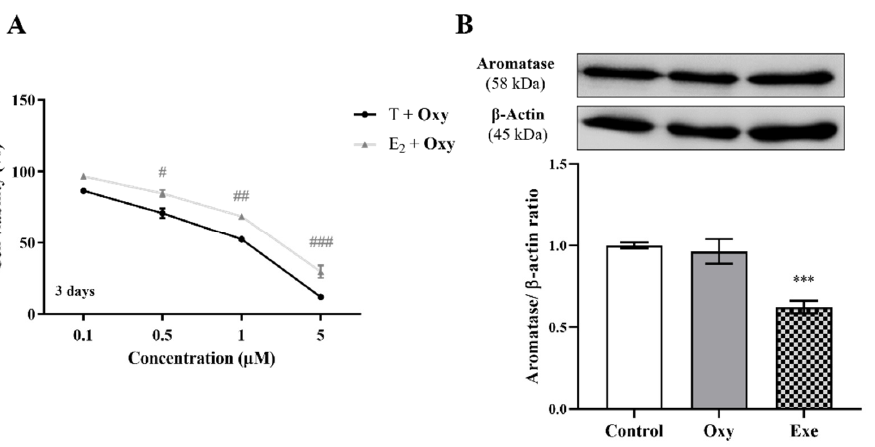
Figure 4. Involvement of aromatase in the effects induced by Oxy on breast cancer cells. ( A ) Effects of Oxy (0.1–5 µ M) on viability of MCF-7aro cells stimulated with T (1 nM) or E 2 (1 nM), after 3 days of exposure. ( B ) Effects of Oxy (1 µ M) on aromatase protein expression levels of MCF-7aro cells, after 8 h. Cells without Oxy treatment were considered as control. Exe at 10 µ M was used as a reference AI. For Western Blot, β -actin was used as a loading control, with the densitometry results presented as aromatase/ β -actin ratio. The protein expression obtained for treated cells was normalized in relation to protein expression of control. Results are presented as the mean ± SEM of at least three independent experiments, each performed in triplicate. Significant differences be ‐ tween T ‐ treated and E 2 ‐ treated cells are denoted by # ( p < 0.05), ## ( p < 0.01) and ### ( p < 0.001), while significant differences between the control and Exe ‐ treated cells are shown by *** ( p < 0.001). Regarding ER α , the results demonstrated that, in the presence of the ER α antagonist ICI, Oxy was unable to reduce cell viability, and a significant increase ( p < 0.001) in cell viability was even observed when compared with cells only treated with Oxy (Figure 5A).